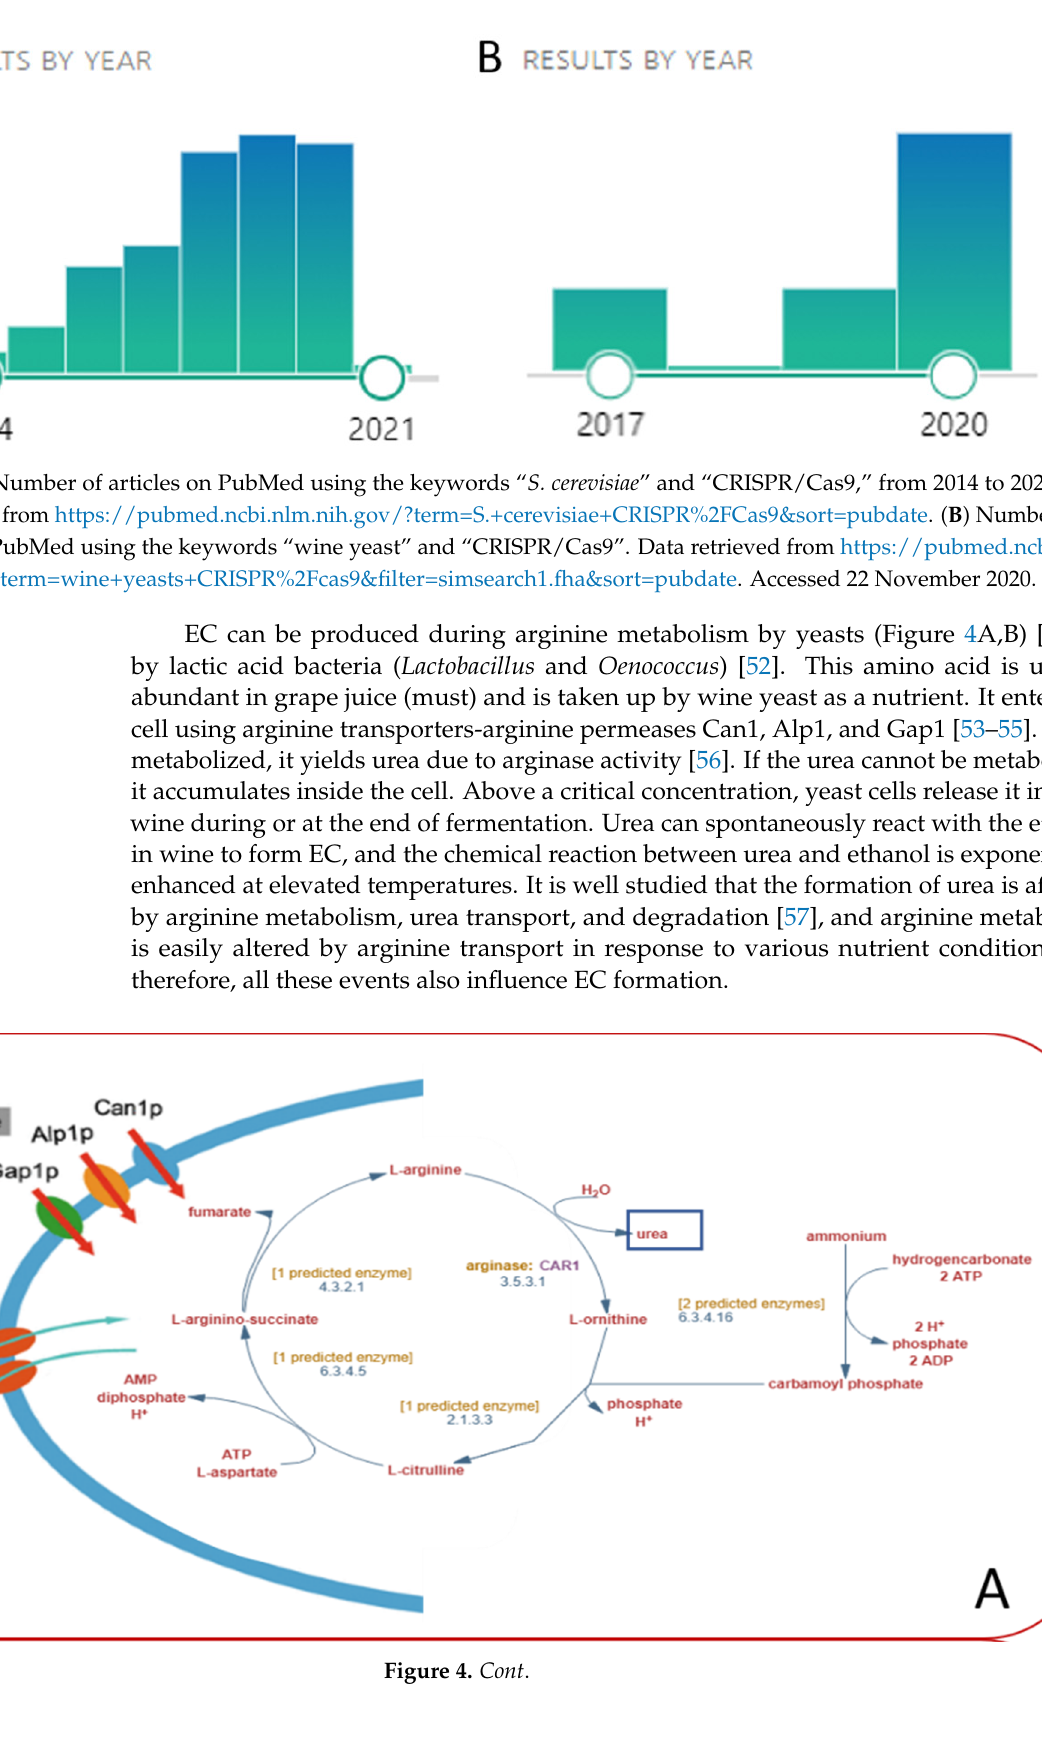
Figure 4. ( A ) Arginine permeases in yeast cells [55] and Saccharomyces cerevisiae S288c Pathway: urea cycle with predicted enzymes and subtracts. Retrieved from https://biocyc.org/YEAST/NEW-IMAGE?type=PATHWAY&object=PWY-4984. Accessed 22 November 2020. ( B ) Precursors and mechanism of ethyl carbamate (EC) formation. The disposal of EC pre- cursors depends on the microorganism present during fermentation. S. cerevisiae degrades arginine to urea and Lactobacilli converts arginine into citrulline. Both compounds react with ethanol producing EC [59]. Wine yeast strains differ in their ability to rapidly catabolize urea during fermenta- tion [56]. When excess urea accumulates in the cell’s cytoplasm, it is released into its en- vironment as must. High urea-producing yeasts are those that have a high capacity to degrade arginine to urea but a low urea-metabolizing ability [60]. Low urea-metabolizing ability may result from the low activity of urea amidolyase, inhibition of amidolyase ac- tivity by the presence of high levels of ammonia, deficiencies of cofactors required by am- idolyase, or low activity due to hyperactive arginase [60]. Genetic as well as environmen- tal factors influence the amount of urea released by the cells. There are, already, some